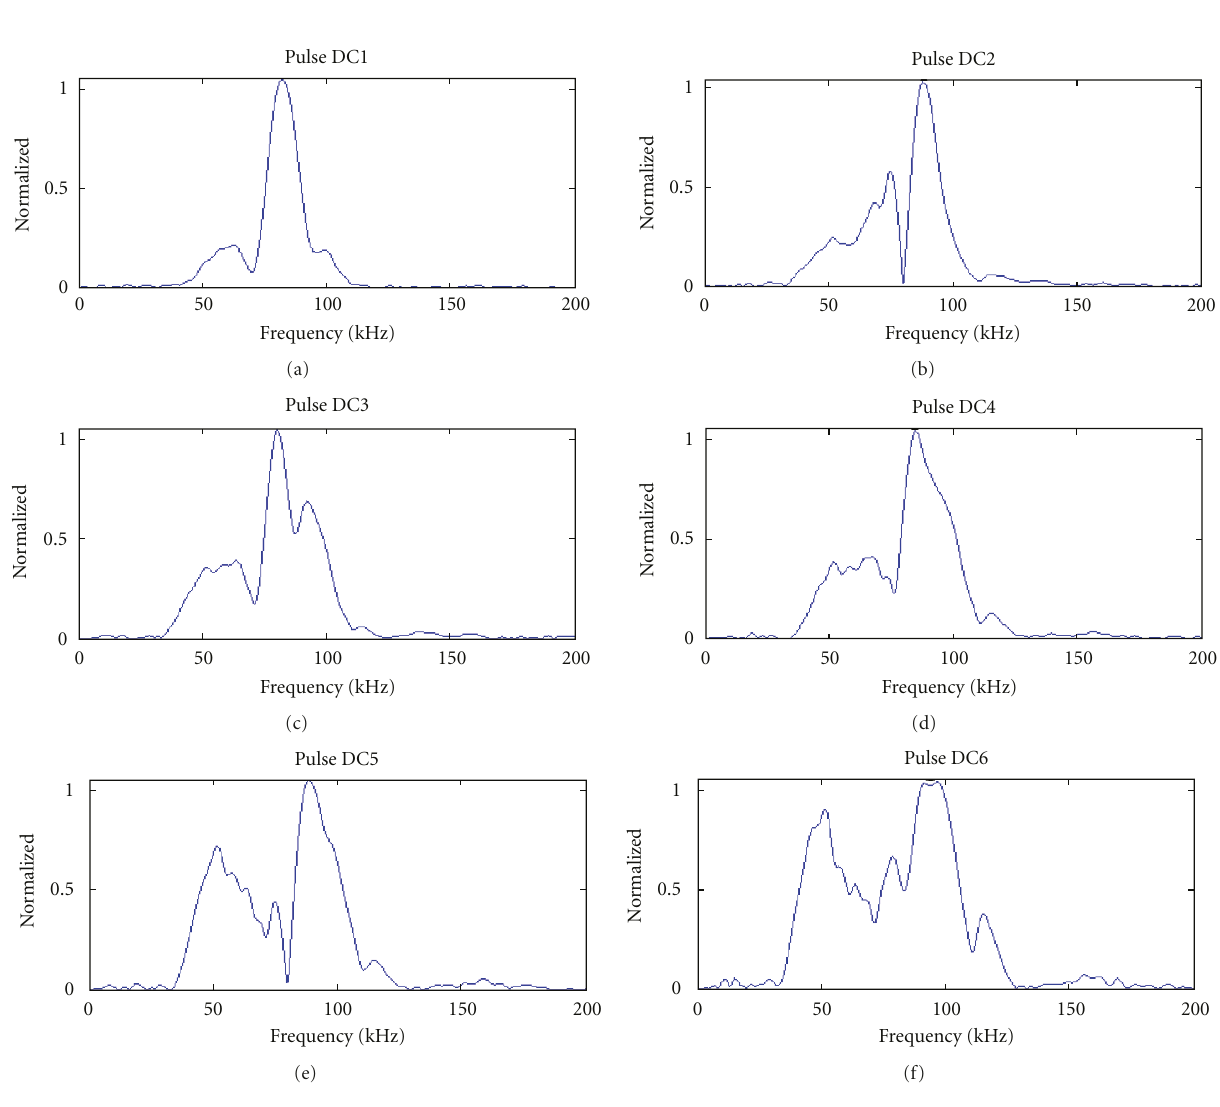
Figure 21: Spectral responses for cable type A, pulses